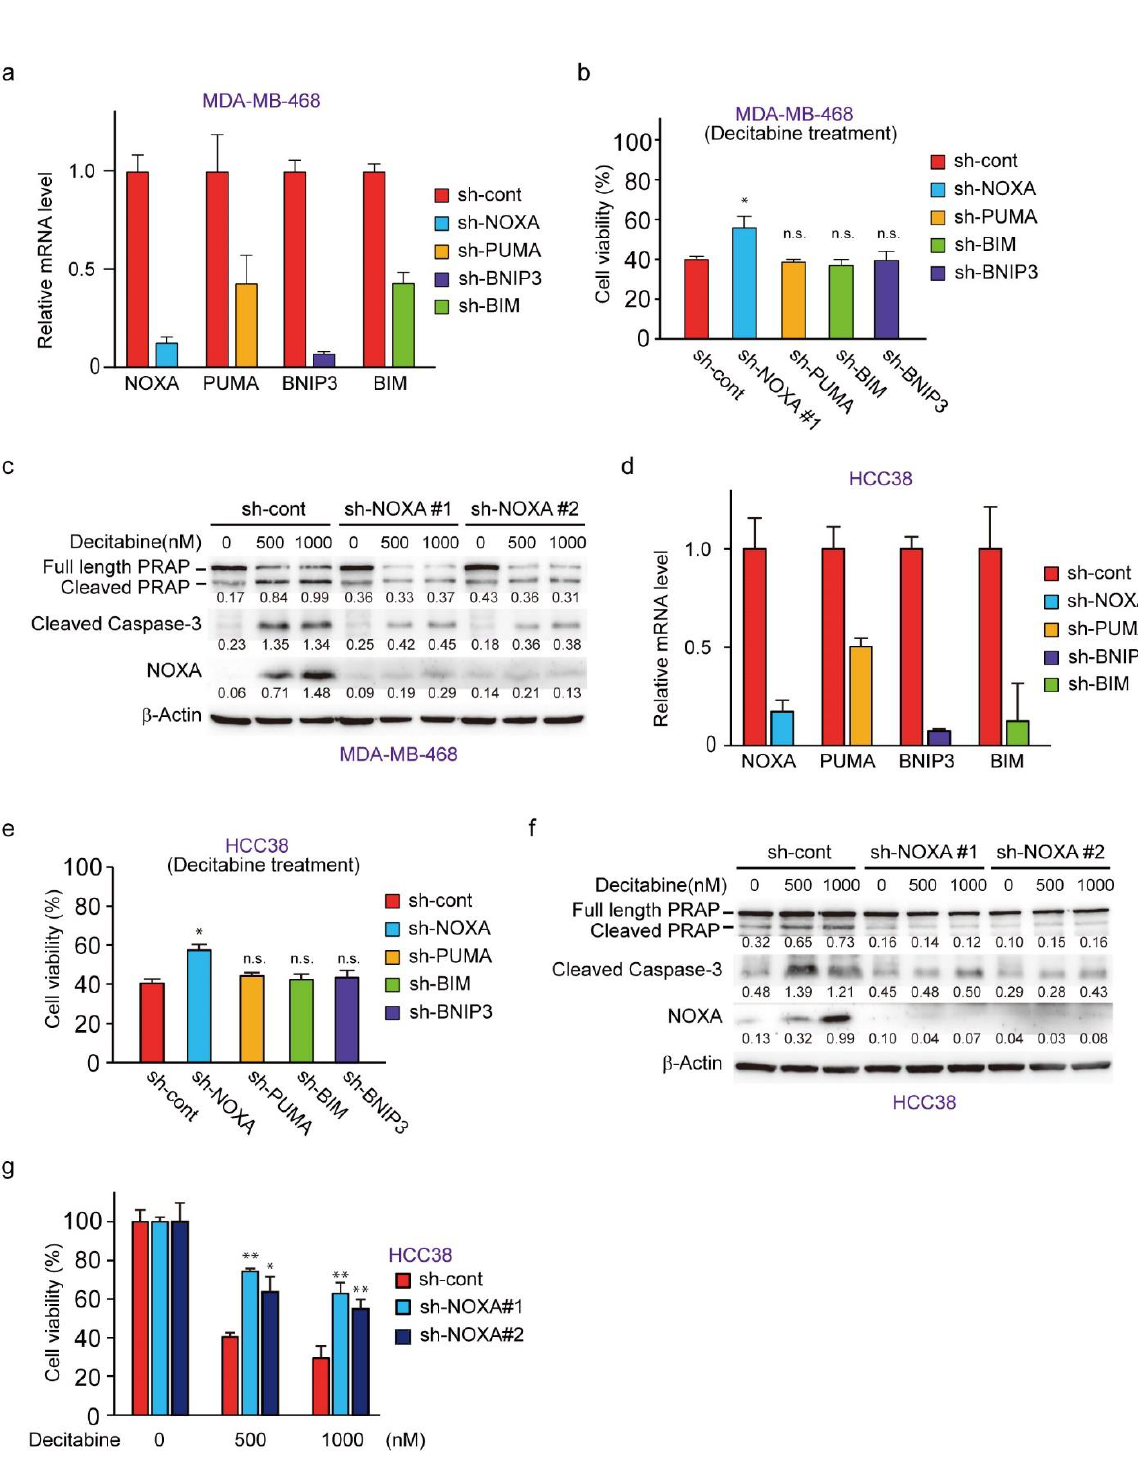
Figure 4. NOXA is a critical component for decitabine-induced apoptosis. ( a ) MBA-MB-468 cells stably expressing shRNA-targeting NOXA (sh-NOXA), PUMA (sh-PUMA), BNIP3 (sh-BNIP3), BIM (sh-BIM), or sh-control were assessed by qPCR. ( b ) MDA-MB-468 cells stably expressing each shRNA were exposed to decitabine (500 nM). After treatment for 72 h, cell viability was measured by CCK-8 analysis. ( c ) MBA-MB-468 cells stably expressing shRNA-targeting NOXA (sh-NOXA-#1, -#2) or sh-control were exposed to the indicated amounts of decitabine (500 or 1000 nM). After treatment for 72 h, equal amounts of total cell lysate were subjected to immunoblot analysis with the indicated antibodies. Numbers below blots represent the relative band intensity of each protein normalized to the signal intensity of β -actin. The uncropped immunoblot images can be found in Figure S3. ( d ) HCC38 cells stably expressing sh-NOXA, sh-PUMA, sh-BNIP3, sh-BIM, or sh-control were assessed by qPCR. ( e ) HCC38 cells stably expressing each shRNA were exposed to decitabine (500